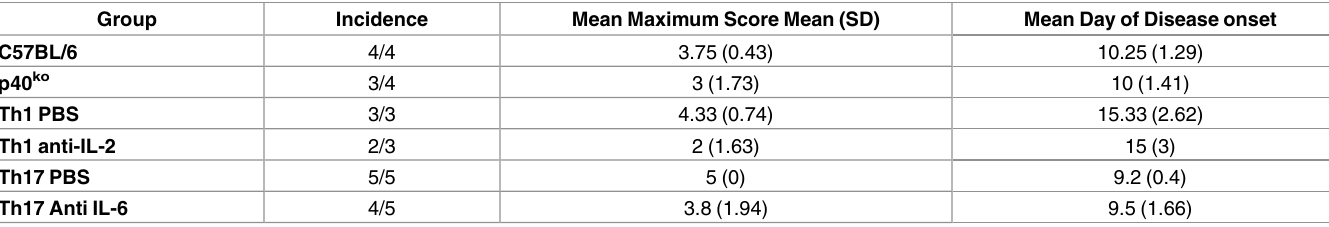
Table 2. Experimental autoimmune encephalitis induced by adoptive transfer.